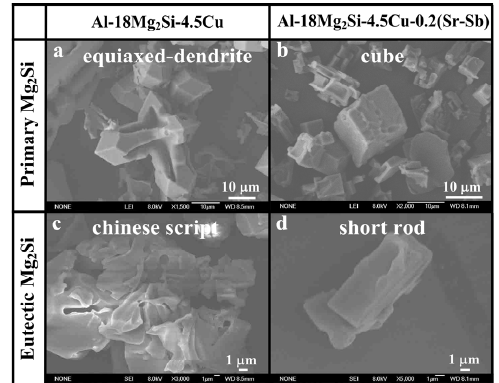
Figure 3. The field emission scanning electron microscope (FESEM) morphology of Mg 2 Si in as ‐